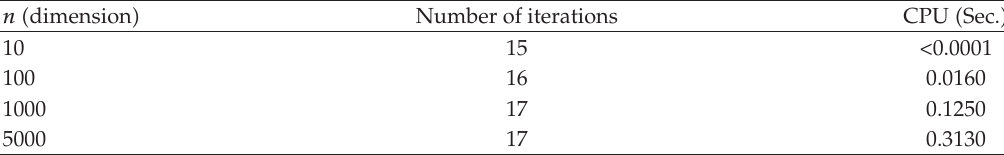
Table 8: Results for Example 6.3 using FB type HRP method.